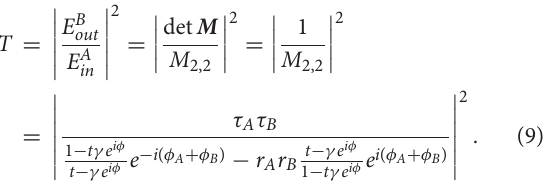
roughness are neglected (i.e., the off-diagonal elements are equal to zero). The surface roughness is considered as a simple radiative loss within the γ